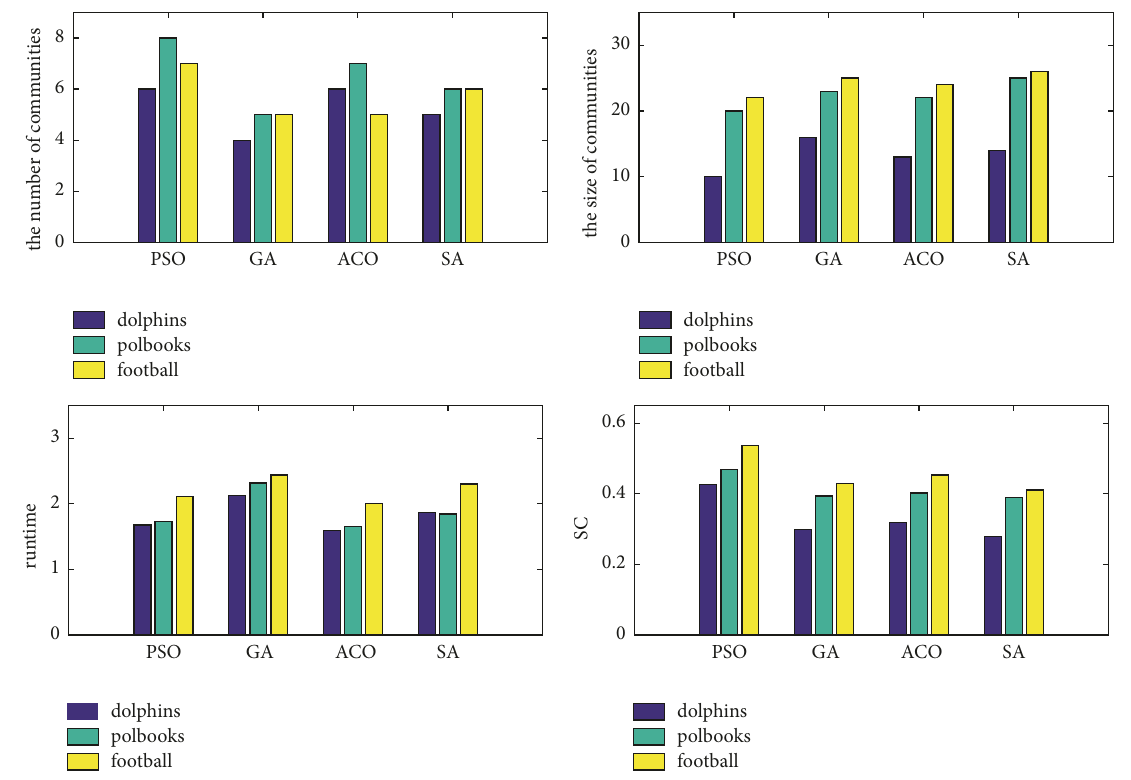
Figure 7: The performance of different optimization algorithms.